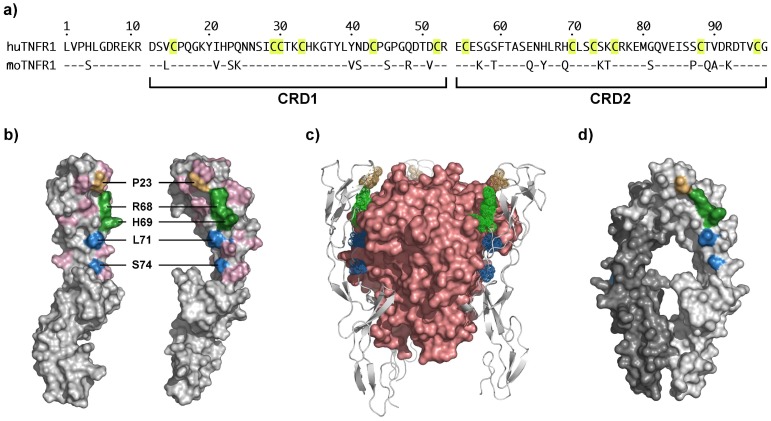
Mapping of the Epitope of ATROSAB on human TNFR1.a) Comparison of amino acids 1–97 of human and mouse TNFR1 b). Positions of the identified residues involved in binding of ATROSAB (orange, green) and Htr-9 (blue) are highlighted. c) Location of the identified residues in the complex of LTα and TNFR1 (pdb entry 1TNF; [44]), colors as in b). d) Location of the identified residues in the TNFR1 dimer (pdb entry 1FT4; [65]), colors as in b). Structures were visualized using Pymol (The PyMOL Molecular Graphics System, Version 1504 Schrödinger, LLC).